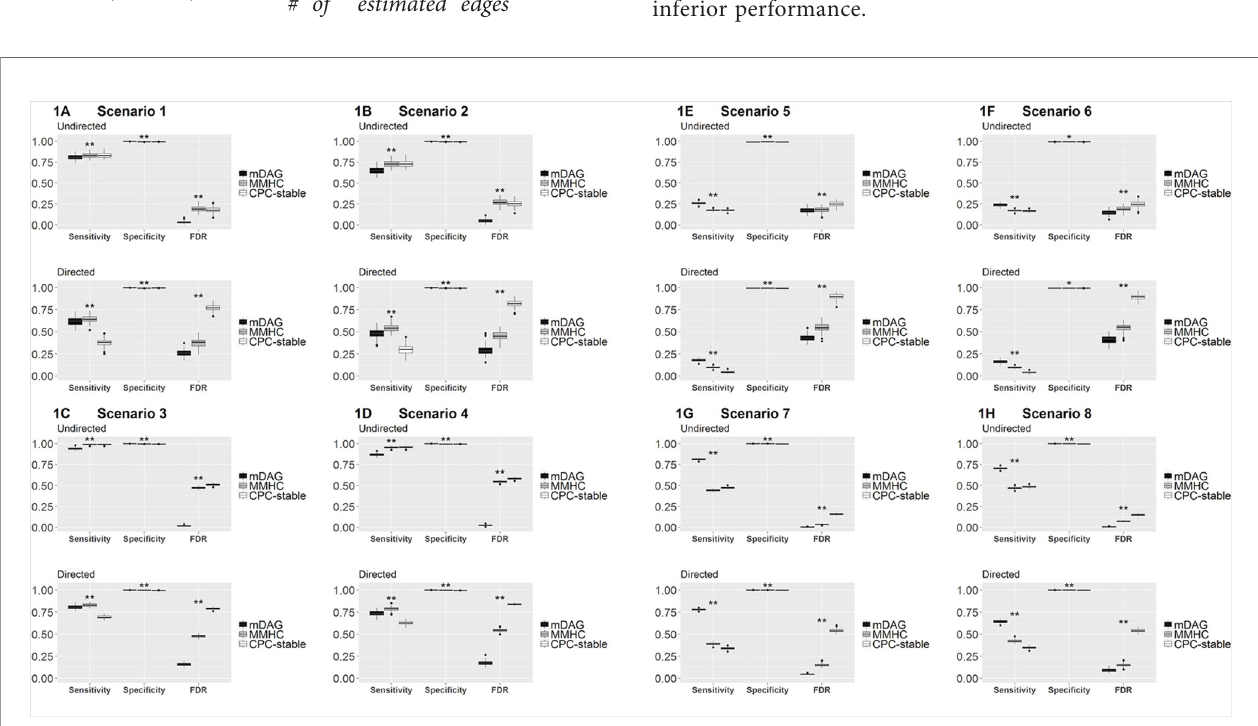
FIGURE 1 | Sensitivity, speci fi city, and FDR of mDAG and two alternative methods, MMHC and CPC-stable, in simulation scenarios 1 – 8. (A) Scenario 1; (B) Scenario 2; (C) Scenario 3; (D) Scenario 4; (E) Scenario 5; (F) Scenario 6; (G) Scenario 7; (H) Scenario 8. The X-axis indicates the measurements of performance (sensitivity, speci fi city, and FDR); the Y-axis indicates the corresponding values. “ * ” indicates the sensitivity/speci fi city/FDR from mDAG signi fi cantly differs from the sensitivity/speci fi city/FDR of CPC-stable or the sensitivity/speci fi city/FDR of MMHC. “ ** ” indicates the sensitivity/speci fi city/FDR from mDAG signi fi cantly differs from the sensitivity/speci fi city/FDR of CPC-stable and the sensitivity/speci fi city/FDR of MMHC. Such comparisons are tested by two-sample